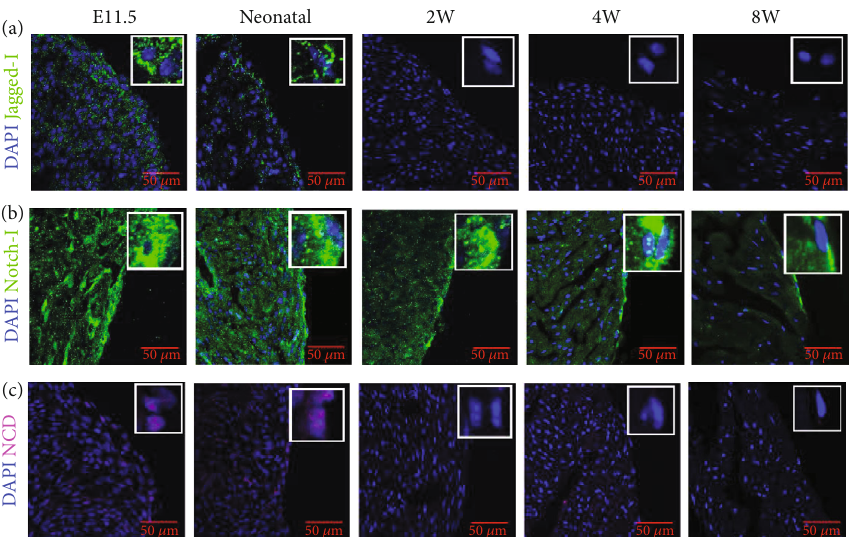
Figure 5: The dynamic changes of Notch signaling in mouse epicardium. (a) The dynamic changes of Jagged-1 in mouse epicardium at di ff erent ages. Jagged-1 was mainly expressed in the heart of E11.5 and neonatal mice. (b) The dynamic changes Notch-1 in mouse epicardium at di ff erent ages. Notch-1 expression in the mouse epicardium gradually decreased from E11.5 to postnatal 8-week-old mice. (c) The dynamic changes of NICD (activated Notch-1) in epicardium in mice at di ff erent ages. NICD was found in epicardium at E11.5 and neonatal mouse but not found in epicardium at postnatal 2-, 4-, and 8-week-old